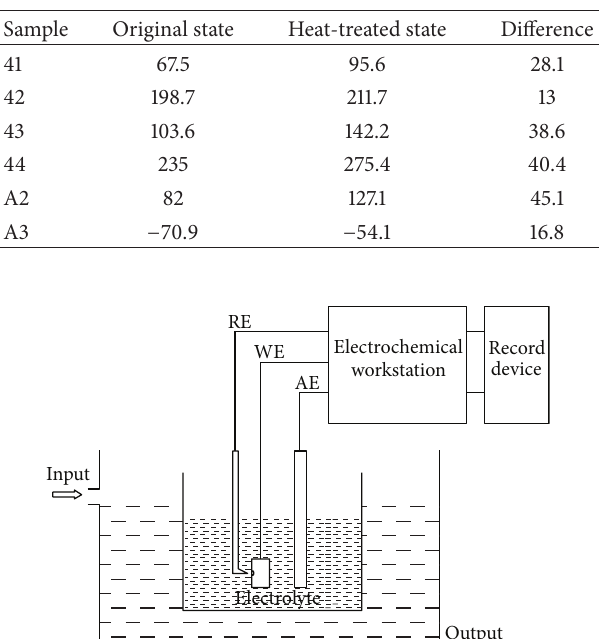
Table 2: The FATT